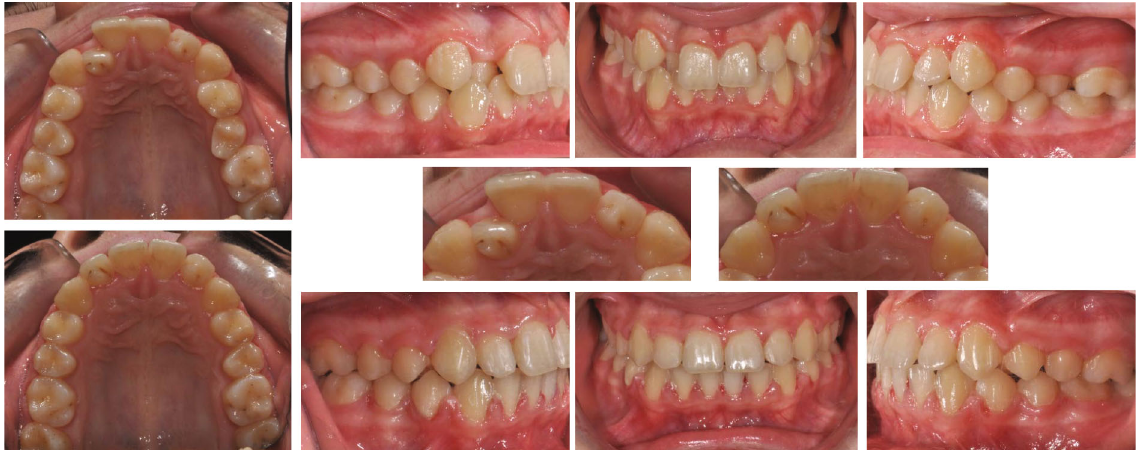
Figure 3: Before and after treatment: reduction of the dens evaginatus.